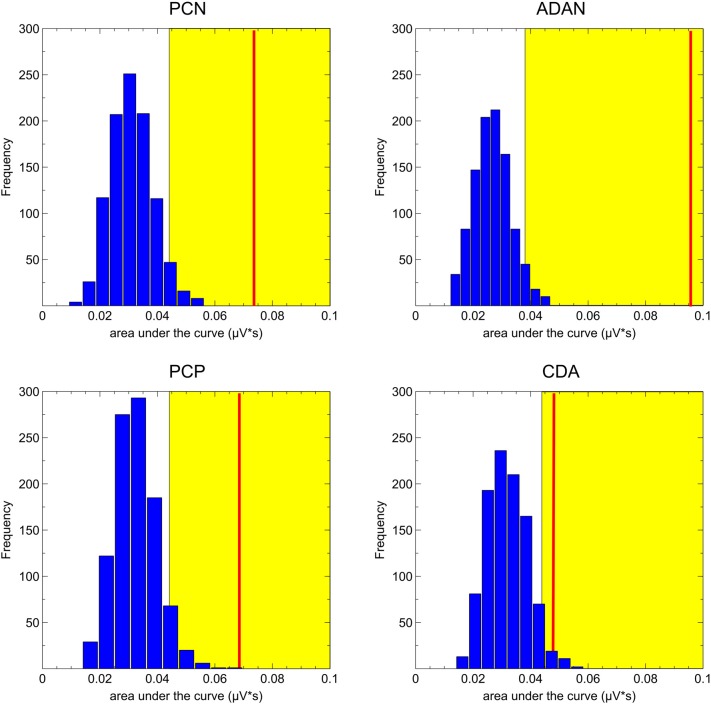
Results of the randomization tests for the ERP asymmetries. The blue bars depict the random distribution of the area under the curve values. The yellow area specifies all values higher than 95% of the random distribution and the red line indicates the observed area under the curve value averaged across participants. The asymmetries were considered as statistically significant when the red line lay within the yellow area.